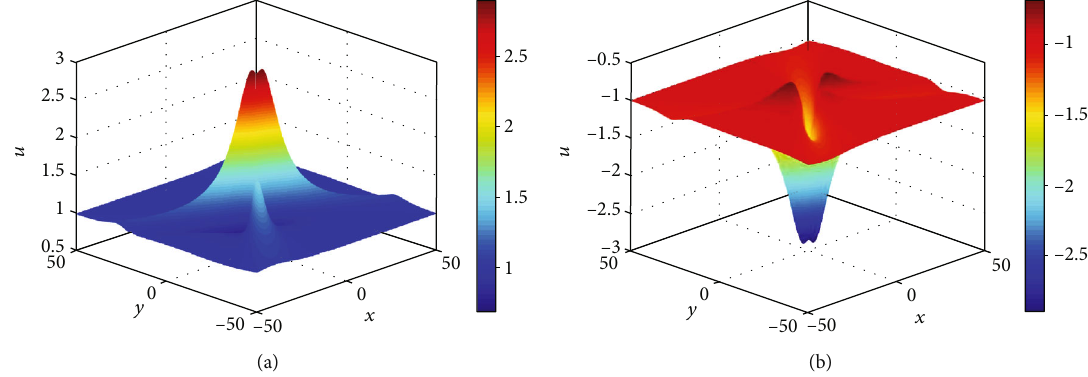
= 1 , K = − 2 − i , K = − 2 + i , P = 2 , P = 2 , 0 1 2 1 2